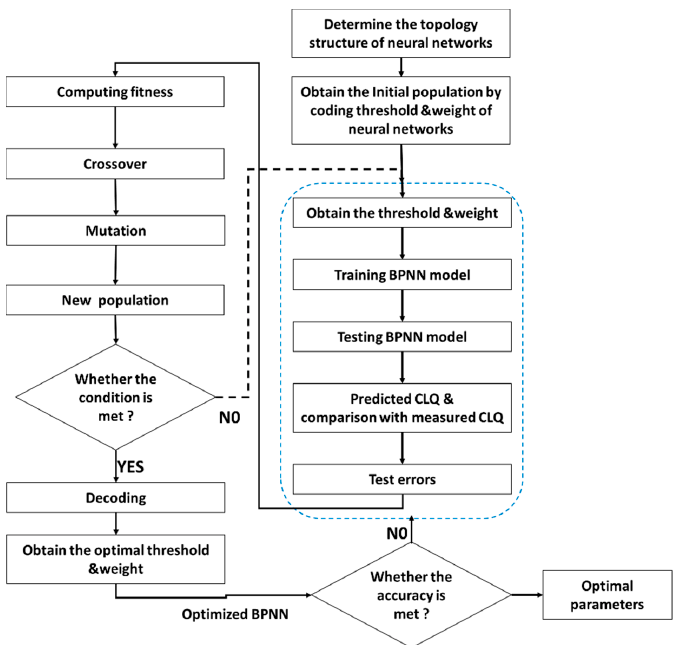
Figure 2. The Flow chart of GA-BPNN.